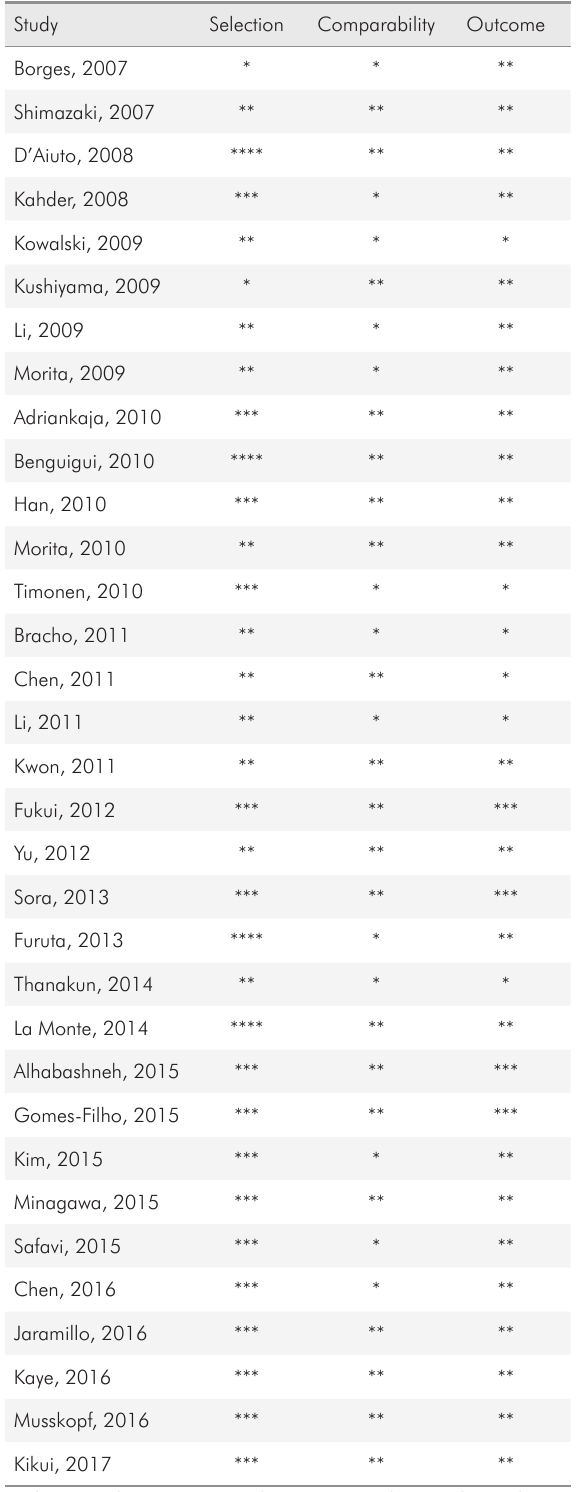
Scale ranges between zero and nine stars. Highest quality studies awarded maximum of four stars for selection, three stars for outcome and two stars for